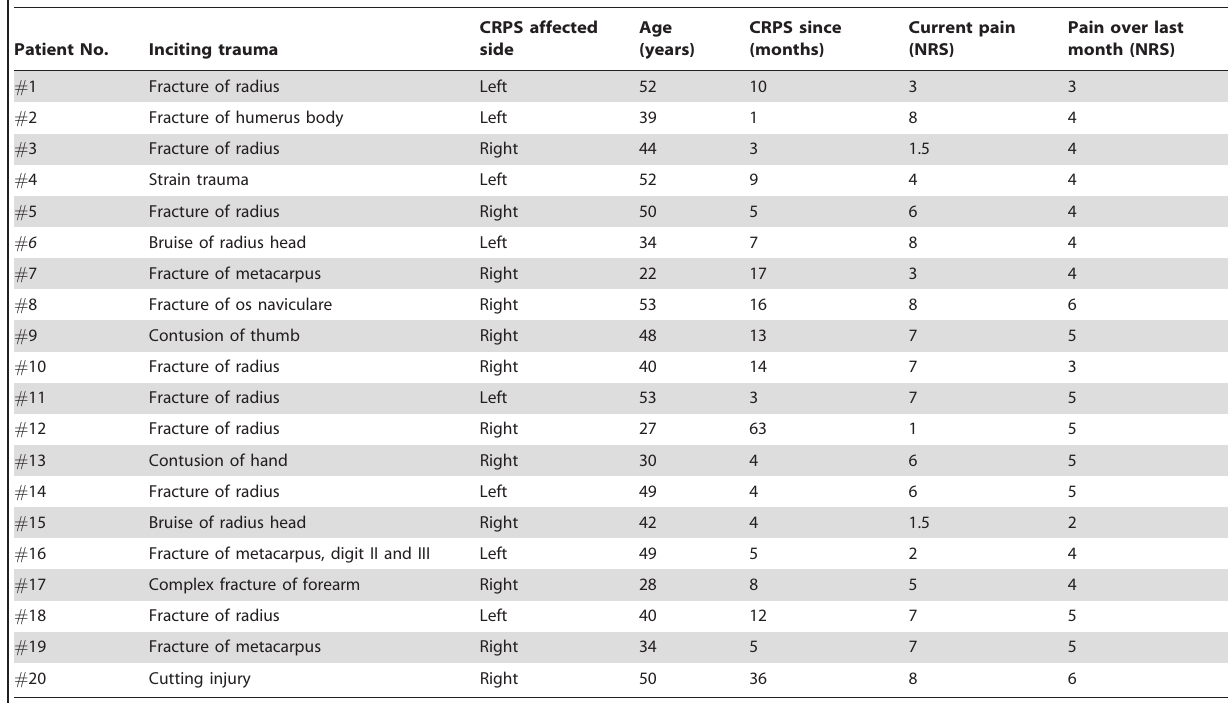
Table 1. Clinical features of CRPS patients.